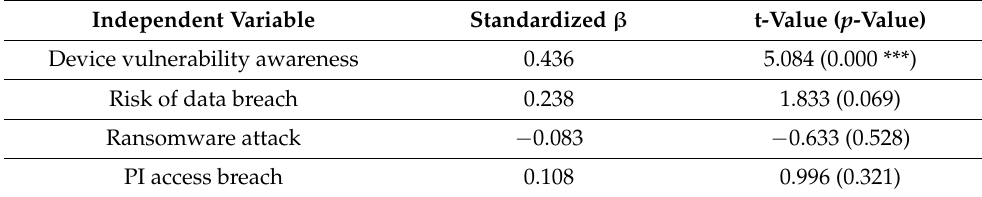
Table 5. Summary of multiple linear regression analysis (standardized coefficients).